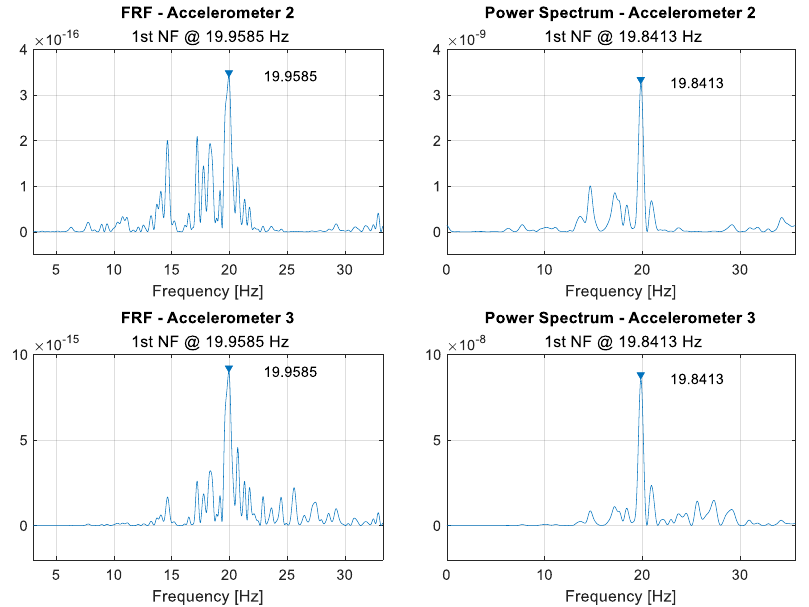
Figure A8. Arduino measurement: 0.5 revolution bolt release .